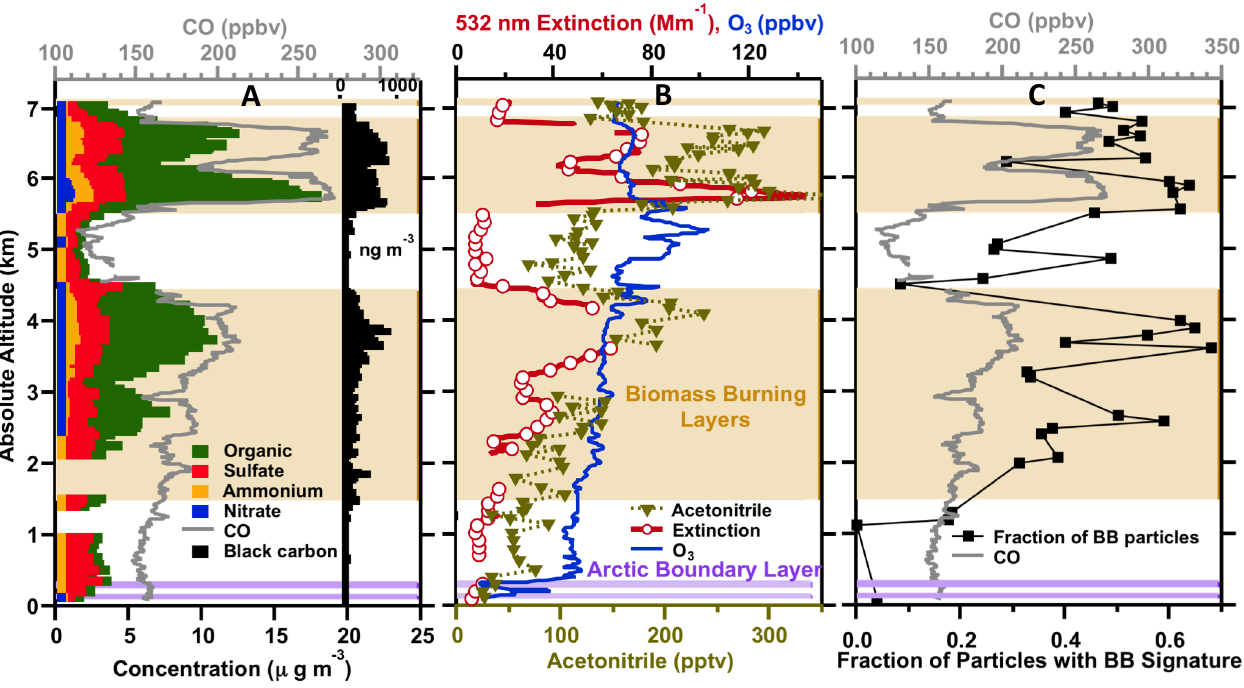
Fig. 3. Vertical profile measured during a slantwise ascent over sea-ice from 22:32–22:57UTC on 18 April 2008 from 72.3 ◦ N, 143.2 ◦ W to 73.1 ◦ N, 137.7 ◦ W. (A) submicron particle composition measured by the AMS, CO mixing ratio, and BC concentration. (B) aerosol extinction, O 3 , and acetonitrile mixing ratios. Tan and purple shading show regions identified as being directly influenced by BB, and being within the ABL, respectively. Regions with no shading are in the “background” category. (C) mixing ratio of CO and number fraction of particles with aerodynamic diameters < 0.7µm classified as containing a biomass/biofuel burning component by the PALMS instrument. Data gaps are instrument calibrations or